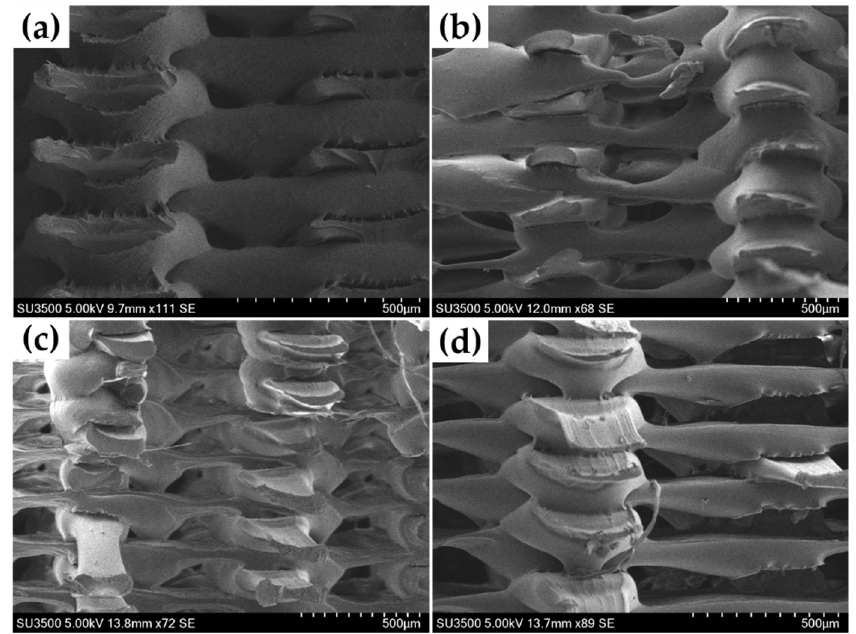
Figure 7. Representative SEM of fracture morphology of PEEK samples printed with different parameters. ( a ) Experiment No. 3; ( b ) Experiment No. 6; ( c ) Experiment No. 7; ( d ) Experiment No. 13. The verification experiment was carried out with the optimal parameters ( 𝐴 (cid:2872) 𝐵 (cid:2871) 𝐶 (cid:2871) 𝐷 (cid:2871) 𝐸 (cid:2869) and 𝐴 (cid:2869) 𝐵 (cid:2870) 𝐶 (cid:2871) 𝐷 (cid:2871) 𝐸 (cid:2870) ) obtained through the orthogonal experiment. The results showed that samples printed with parameters 𝐴 (cid:2872) 𝐵 (cid:2871) 𝐶 (cid:2871) 𝐷 (cid:2871) 𝐸 (cid:2869) had the minimum warpage deformation, which was reduced to almost 0, and the tensile strength was 41.52 (cid:3399) 1.84 MPa. In contrast, samples printed with parameters 𝐴 (cid:2869) 𝐵 (cid:2870) 𝐶 (cid:2871) 𝐷 (cid:2871) 𝐸 (cid:2870) had the largest tensile strength of 48.50 (cid:3399) 0.96 MPa, improved by 19.6% compared to the optimization result before preliminary optimization (samples printed with 0°/90° raster angle and 50% infill density had a tensile strength of 40.56 (cid:3399) 1.41 MPa), while the warpage was 0.52 (cid:3399) 0.08 mm. Both of them were better than the best results of the previous experiment group. The excellent performance shows the correctness and reliability of the orthogonal experiment. The final result is different from the nominal strength. This is because printed samples in our experiment used 50% infill density, which will have the highest specific strength and is of greater significance for lightweight design. 3.3. Discussion 3.3.1. Printing Speed Printing speed is the most important parameter affecting tensile strength. The group with printing speed of 25 mm/s had the highest tensile strength. As printing speed in- creases, the tensile strength shows a downward trend. At a lower printing speed, the sam- ple had a larger filament width and higher strength [46]. Therefore, the strength of the overall sample would be higher. When printing speed increases, the printing efficiency could be improved, but residence time of the filament in nozzle flow channel is small, which is likely to cause incomplete melting and reduce fluidity. It will also cause uneven extrusion, weak interlayer bonding, and poor compactness, which will weaken mechani- cal properties. When printing speed does not exceed 40 mm/s, the effect of printing speed on the amount of warpage is opposite to tensile strength, that is, the increase in printing speed leads to a decrease in the amount of warpage. This phenomenon is probably related to the temperature gradient within each layer. Due to the lower printing speed, it takes longer to complete the printing process for one layer. This leads to a larger temperature gradient